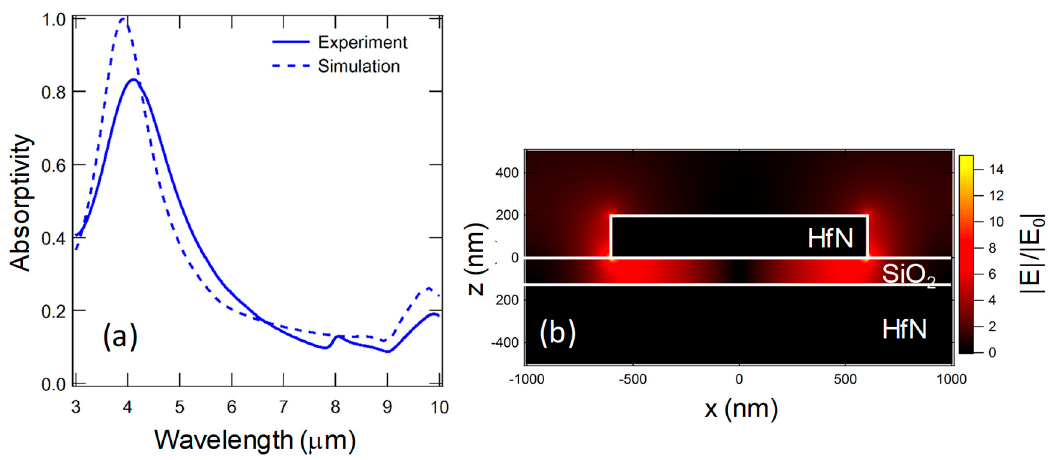
Figure 12. Absorptivity spectra and electric field distribution of the MDM metasurface composed of HfN and SiO 2 with P = 2.0 µm, d = 1.14 µm, T g = 130 nm, and T d = 200 nm: ( a ) measured (solid line) and simulated (dashed line) absorptivity spectra at room temperature, and ( b ) normalized electric field distribution around the meta-atom for the resonance at 4.11 µm.